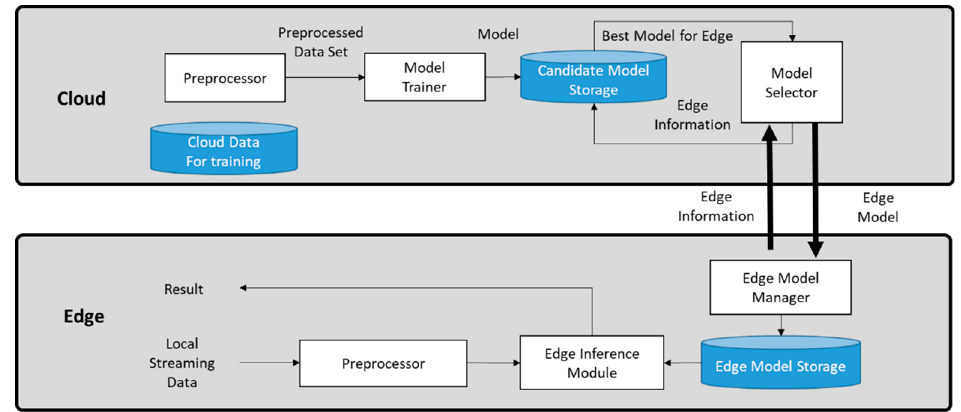
Figure 2. Proposed framework structure.